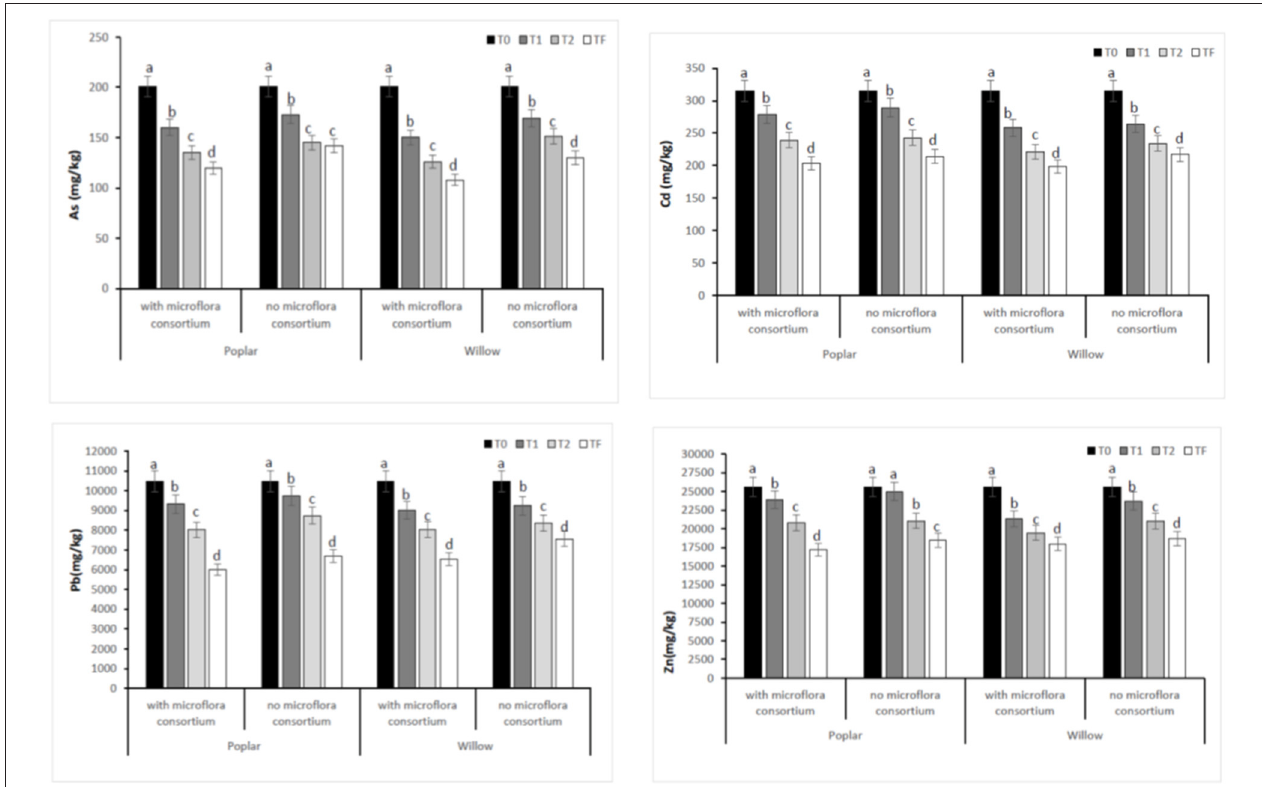
FIGURE 2 | Total concentration of HMs (As, Cd, Pb, and Zn) in rhizosphere soil at different monitoring time (T 0 :0, T 1 :12, T 2 :24 and T F : 36 months) with microflora consortium and no microflora consortium in hybrid poplar Populous deltoids × Populous nigra and in willow Salix purpurea subsp. lambertiana . Mean values ± SE.